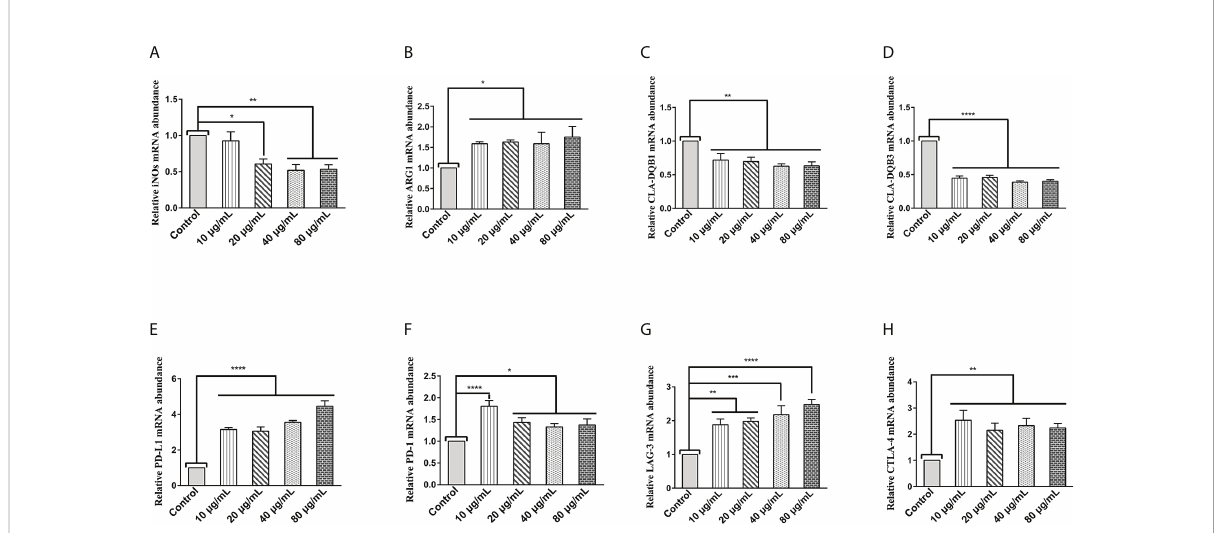
FIGURE 1 HcESPs upregulated the transcript levels of Arg1 and immune checkpoint molecules in PBMCs, while downregulated the transcript levels of iNOs and MHC II in PBMCs. Cells were incubated with different concentrations (10, 20, 40, 80 m g/mL) of HcESPs or an equal volume of RPMI 1640 medium (control) at 37°C and 5% CO 2 for 24 h. (A, B) The transcript levels of iNOs and Arg1 were detected by qPCR assay; (C, D) The transcript levels of MHC II (CLA-DQB1 and CLA-DQB3) were detected by qPCR assay; (E-H) The transcript levels of immune checkpoints molecules (PD-L1, PD-1, LAG-3, CTLA-4) were detected by qPCR assay; Data are presented as the mean±SEM from three independent experiments. * P <0.05, ** P <0.01, *** P <0.001, **** P <0.0001 vs the control